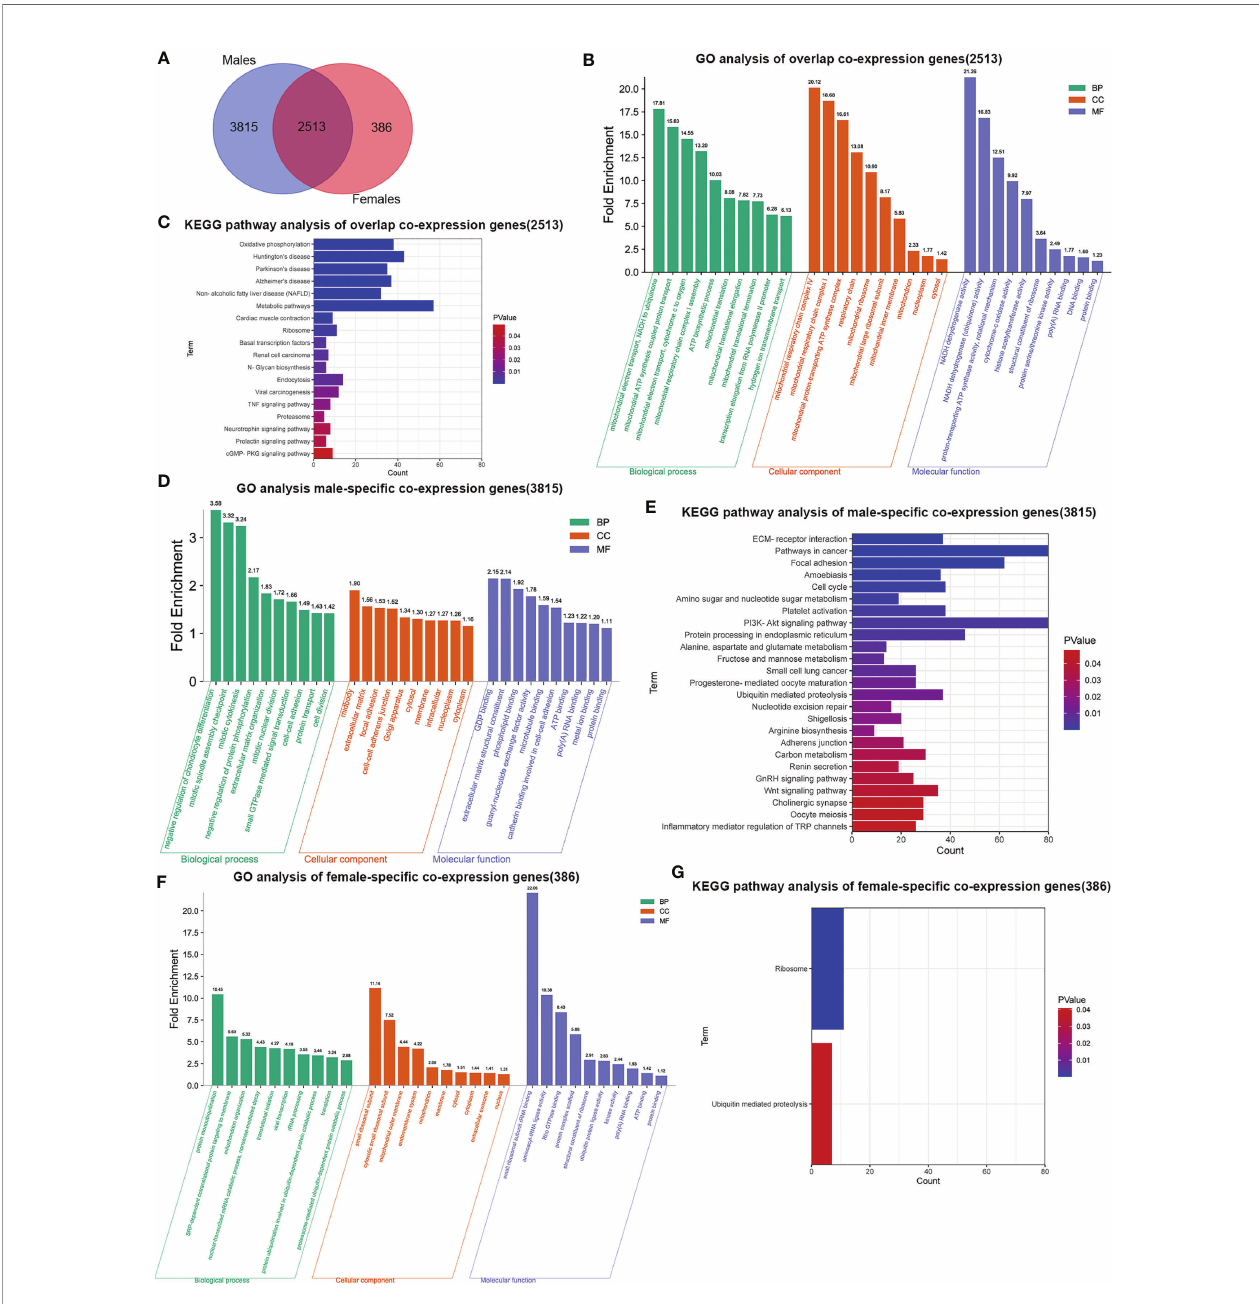
FIGURE 5 | Sex differences in signi fi cant GO terms and KEGG pathways analysis. (A) Venn diagrams show the number of distinct and overlapping DEGs in male and female HCC patient group. (B) Enriched BP, CC and MF GO terms of 2513 overlap co-expression genes. Vertical axis represents GO terms. Fold enrichment was marked on the top of column. (C) . Signi fi cant KEGG pathways of 2513 overlap co-expression genes, P values are marked in different colors. (D) Enriched BP, CC and MF GO terms in 3815 male-speci fi c co-expression genes. (E) Signi fi cant KEGG pathways of 3815 male-speci fi c co-expression genes. (F) Enriched BP, CC and MF GO terms in 386 female-speci fi c co-expression genes. (G) Signi fi cant KEGG pathways of 386 female-speci fi c co-expression